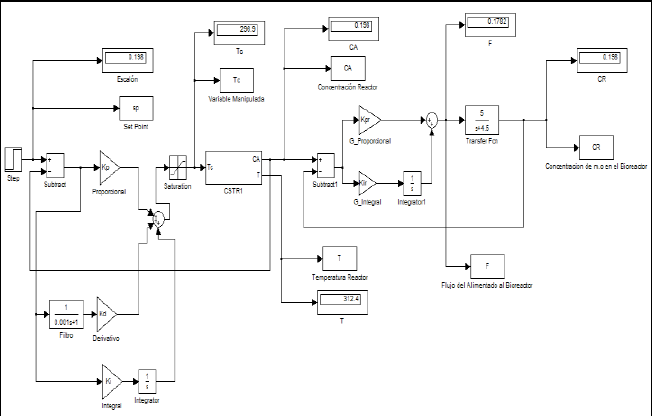
Figura 12: Diseño en Simulink del controlador PI para el Bioreactor, segunda etapa de la planta completa planta de procesamiento químico compuesta por un reactor exotérmico de simple camisa y de tanque continuamente agitado (CSTR) y un Bioreactor continuo de mezclado perfecto.